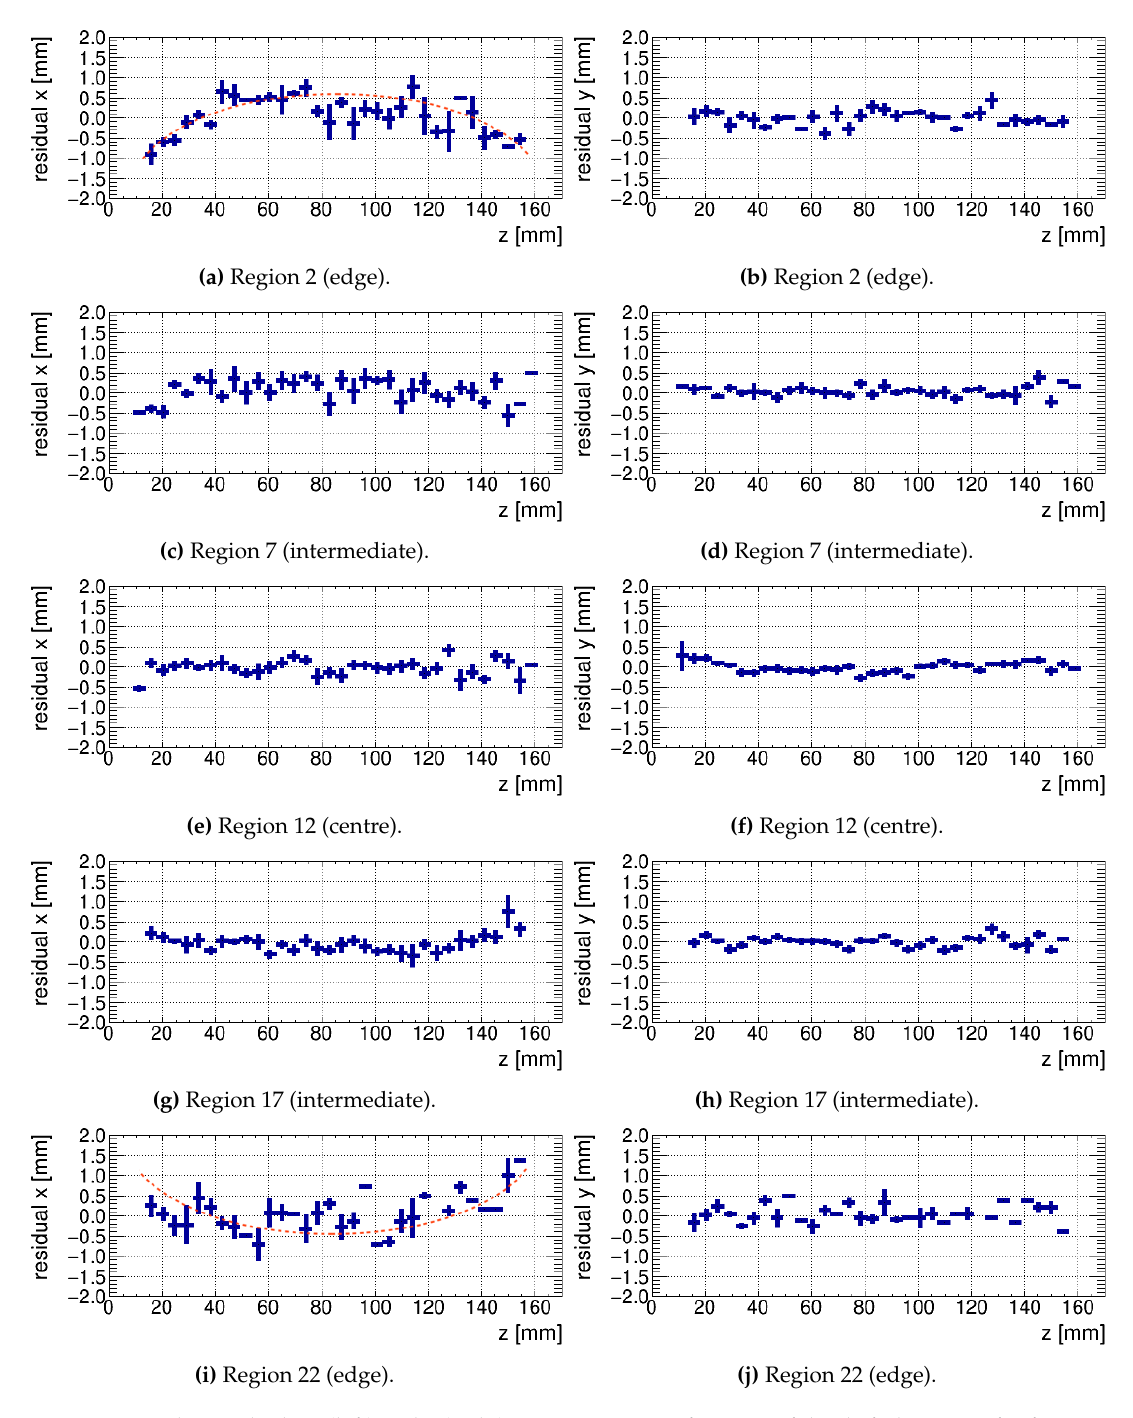
Figure 9. The residual’s x (left) and y (right) components as a function of the drift distance z for five adjacent regions. Dashed orange lines are used to illustrate the